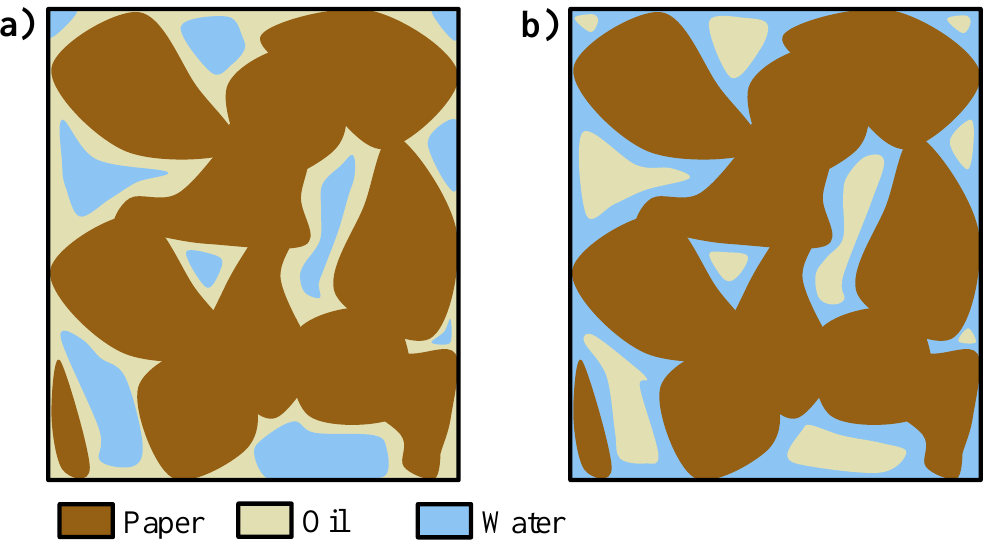
Figure 6. ( a ) Domains of water in oil at t 0 and ( b ) domains of oil in water at t f [15,16].